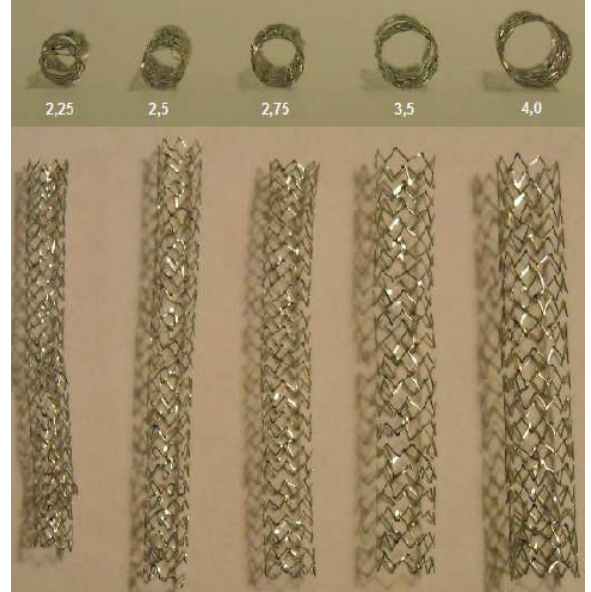
Figure 4. The investigated